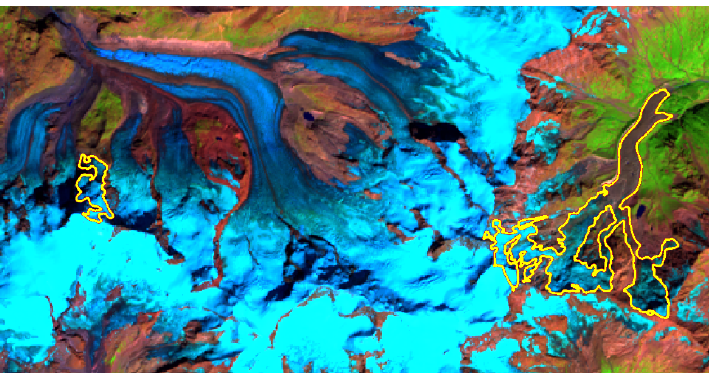
Figure 13. Two glaciers were discarded from our study (yellow outlines), the Ghiacciaio di Belvedere ( right ) and a small overhanging glacier in the north face of the central Breithorn peak ( left